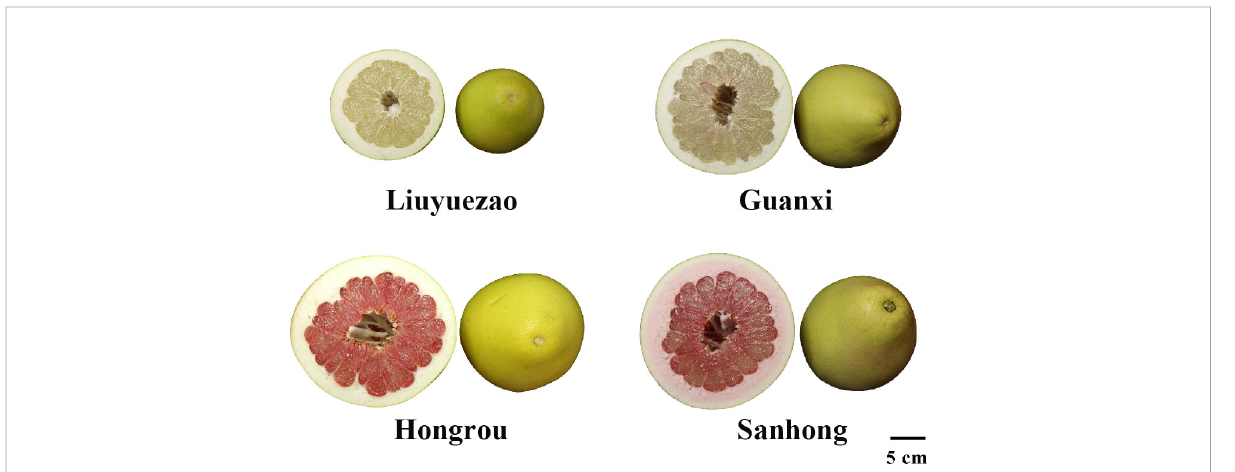
FIGURE 1 Fruits of the four pummelo